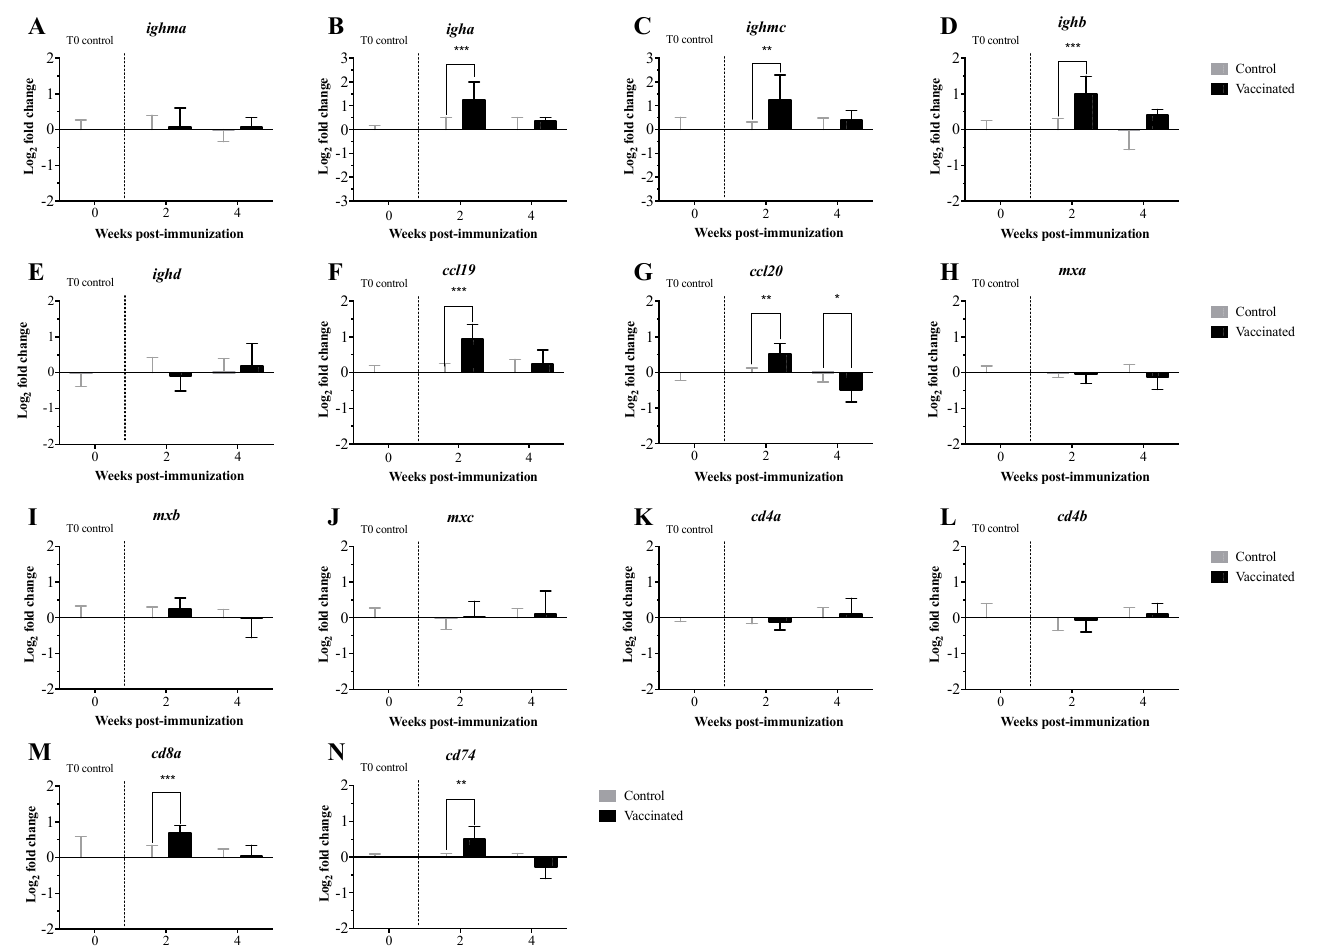
Figure 5. Transcript expression levels of immunoglobulin heavy locus genes, cytokine CC genes and interferon-induced GTP-binding proteins genes, and cluster of differentiation genes in lumpfish larvae orally immunized with the V. anguillarum bacterin bio-encapsulated in A. salina nauplii ( A – E ). Immunoglobulin heavy locus genes ( F – J ). Cytokine CC genes and interferon-induced GTP-binding proteins genes ( K – N ). Cluster of differentiation genes. Transcript expression levels were assessed pre-immunization (T0 control, n = 3 individual pools of 10 larvae each), 2 weeks post-immunization ( n = 3 pools of 10 larvae each), and 4 weeks post-immunization ( n = 3 pools of 5 larvae each). Time point controls post-mock immunization were collected in a similar fashion to those collected at weeks 2 and 4. Relative expression was calculated using the 2 ( −∆∆ Ct) method and normalized using log 2 ; etif3d and rpl32 were used as endogenous controls. A two-way ANOVA test followed by the Sidak multiple comparisons post hoc test were used to assess significant differences between the treatments (control and vaccinated) at each individual time point. Asterisks (*) represent significant differences (* p < 0.05, ** p < 0.01, *** p < 0.001).